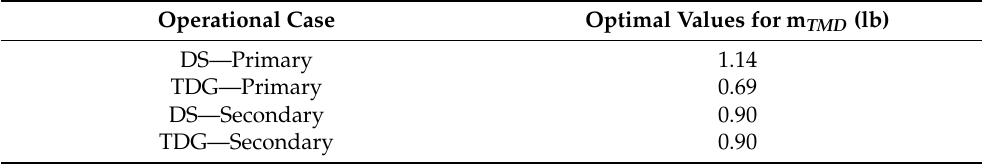
Figure 14. Comparison of the time response functions for the RSSQ deviation angle, considering all best individuals of each configuration investigated, obtained with the utopian point method. The ( a ) graph presents the results for the primary operational case modelled with the TDG, while the ( b ) graph represents the secondary operational case.